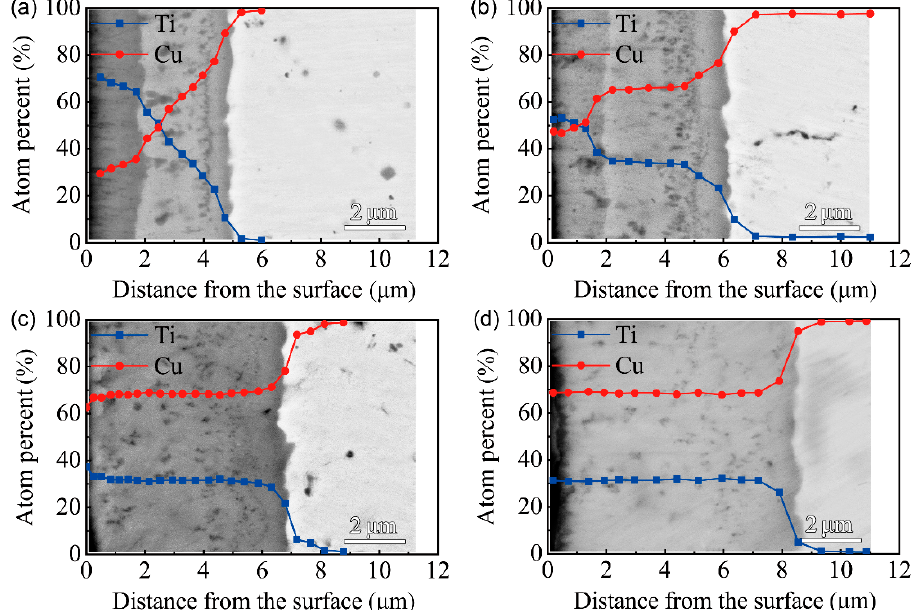
Figure 4. BSEM images (back-scattered electron image) of the cross-section and EDS results of F1 film on the C17200 Cu alloy after thermal diffusion: ( a ) 650 °C for 1 h; ( b ) 650 °C for 4 h; ( c ) 750 °C for 1 h; ( d ) 750 °C for 4 h.